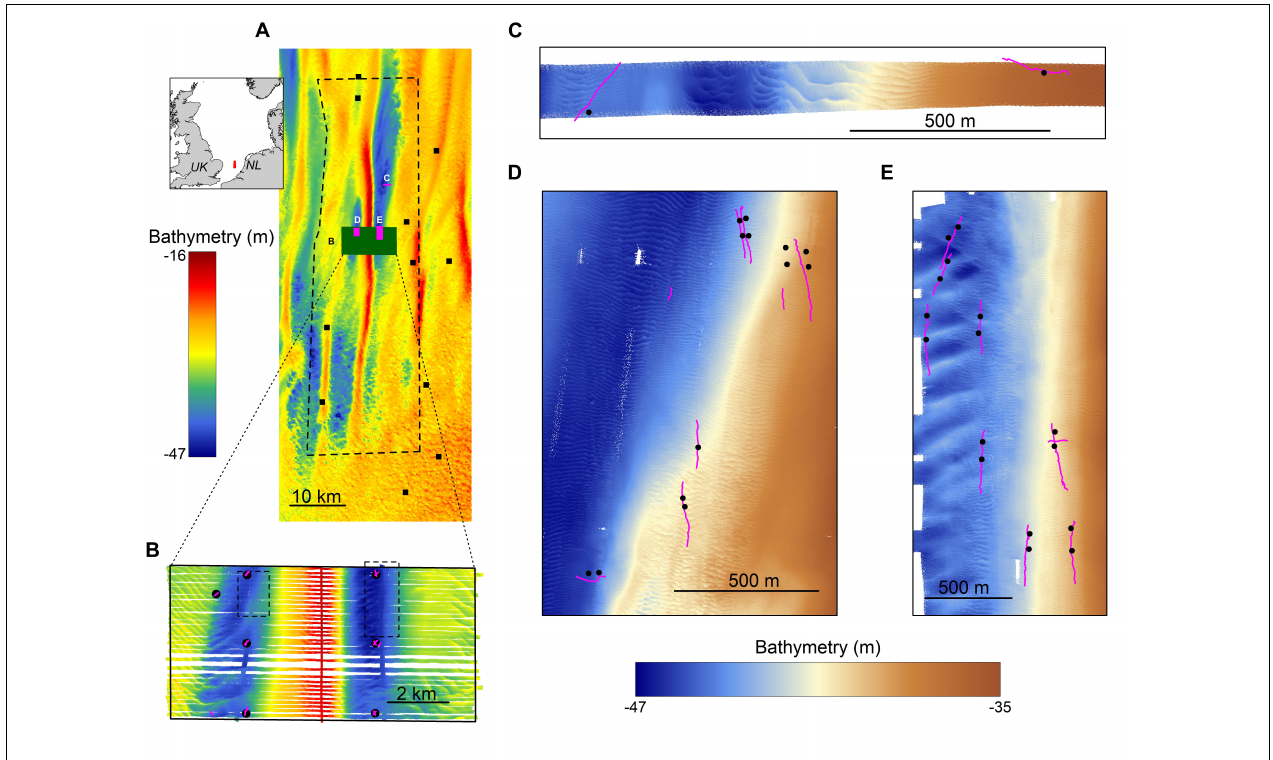
FIGURE 1 | The study area. (A) an overview of the Brown Bank area including bathymetry, sampling locations for the MWTL- survey (squares) and the locations of more intensively studied areas displayed in other panels. Inset shows the location of the study area within the North Sea. (B) an overview of data gathered in the research campaign of 2017, showing bathymetry data (background), boxcores (black circles) and video transect locations (pink lines) and the locations of panels (C,D) (dotted lines). (C–E) close-up of the three survey areas in the 2019 campaign, showing bathymetry data, boxcore and video transect locations. Note the differences in bathymetry color scales used for panels (A,B) and (C–E)